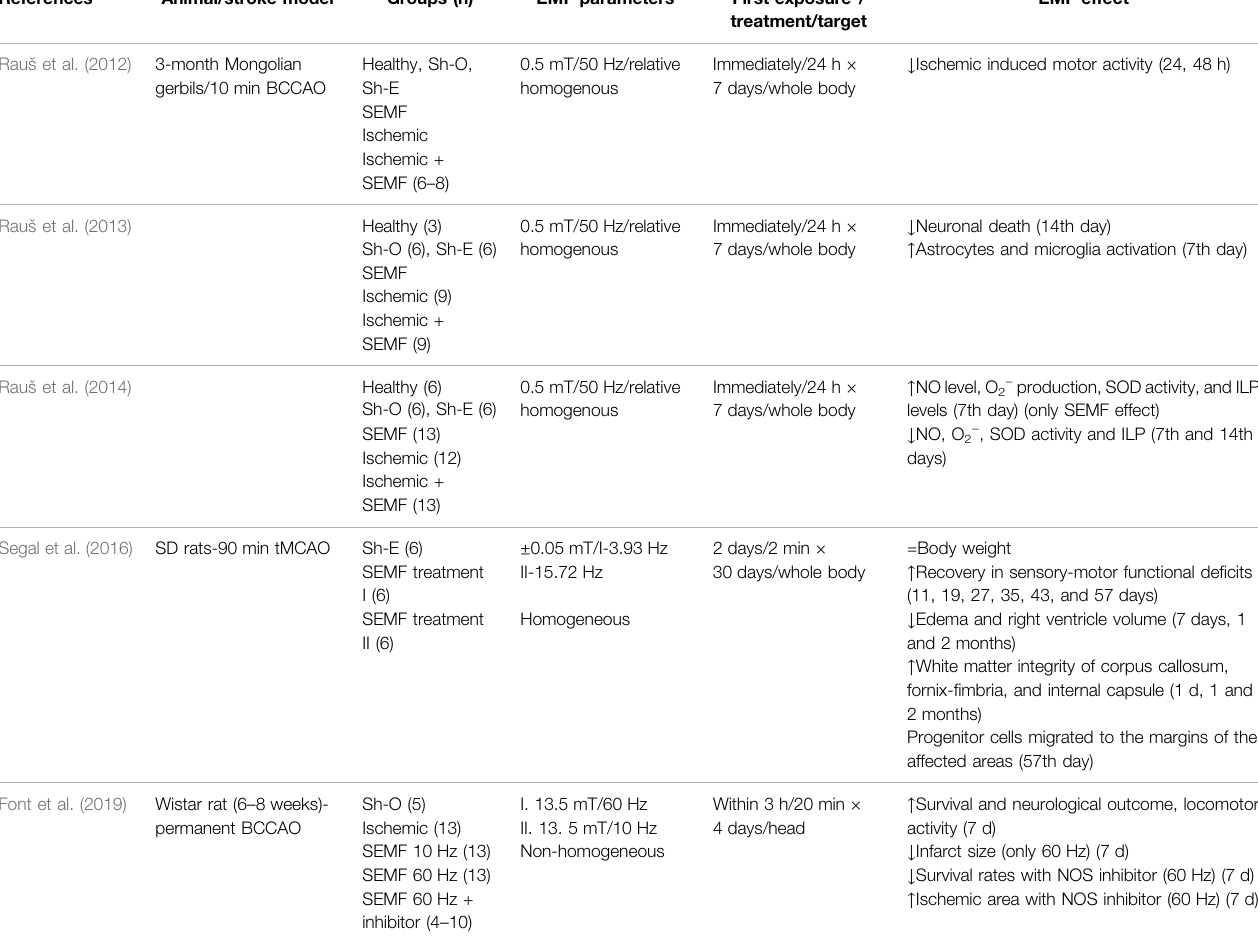
TABLE 4 | Overview of in vivo studies using sinusoidal electromagnetic fi eld (SEMF) as a treatment for ischemic